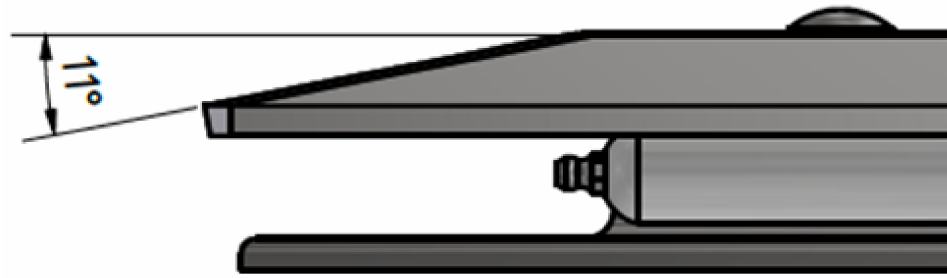
Figure 7. Bent edges of the